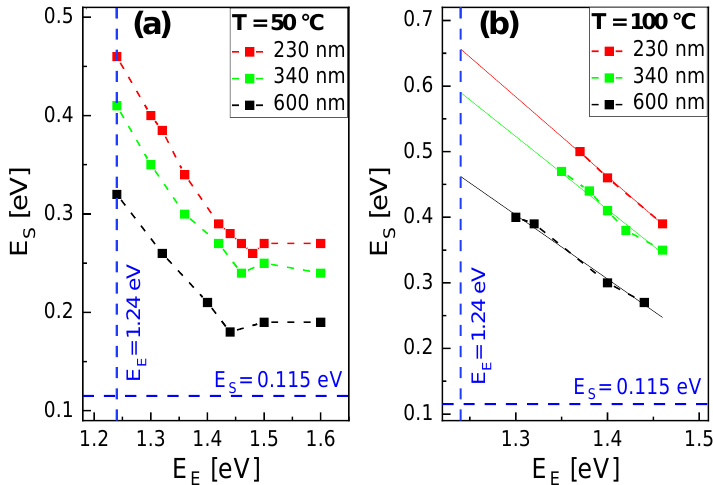
Figure 3. To parameterize the area-selective deposition step, pairs of E E , E S are determined which yield simulated droplet numbers that are in agreement with the experimental values for ( a ) T = 50 °C and ( b ) T = 100 °C. Three aperture diameters d are considered as indicated. The continuous lines in b) show results of linear fits. The dashed blue lines indicate the activation energies obtained for self-assembled droplet formation. Table 2. Two approaches for simulation parameters which reproduce the experimental droplet numbers after area-selective deposition for different aperture diameters d . E E = 1.24 eV is assumed to be constant.